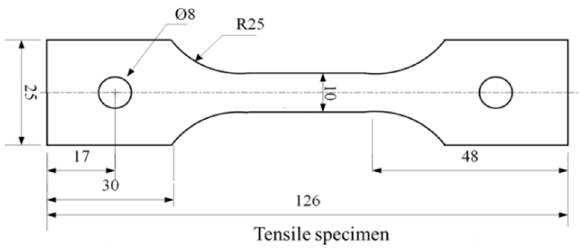
Figure 1. Dimension diagram of the tensile specimen.